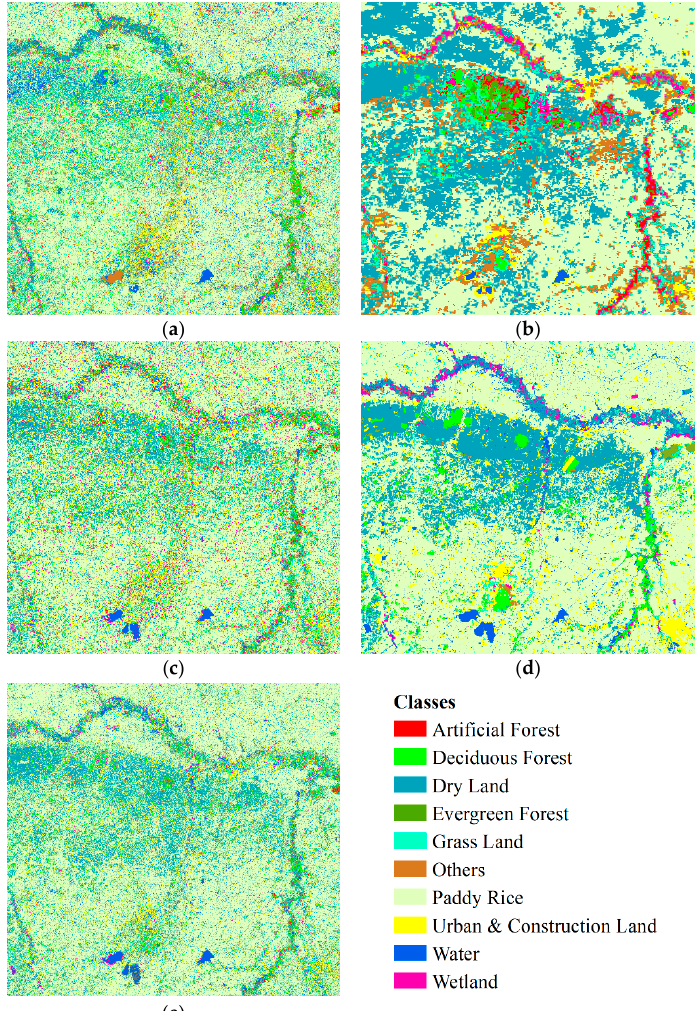
Figure 7. ( a ) Land cover (LC) map with Landsat pixel using NN classifier, ( b ) LC map with MODIS pixels using Euclidean distance (ED) classifier, ( c ) LC map with Landsat objects using NN classifier, ( d ) true LC map, ( e ) LC map using the fusion scheme of this paper.